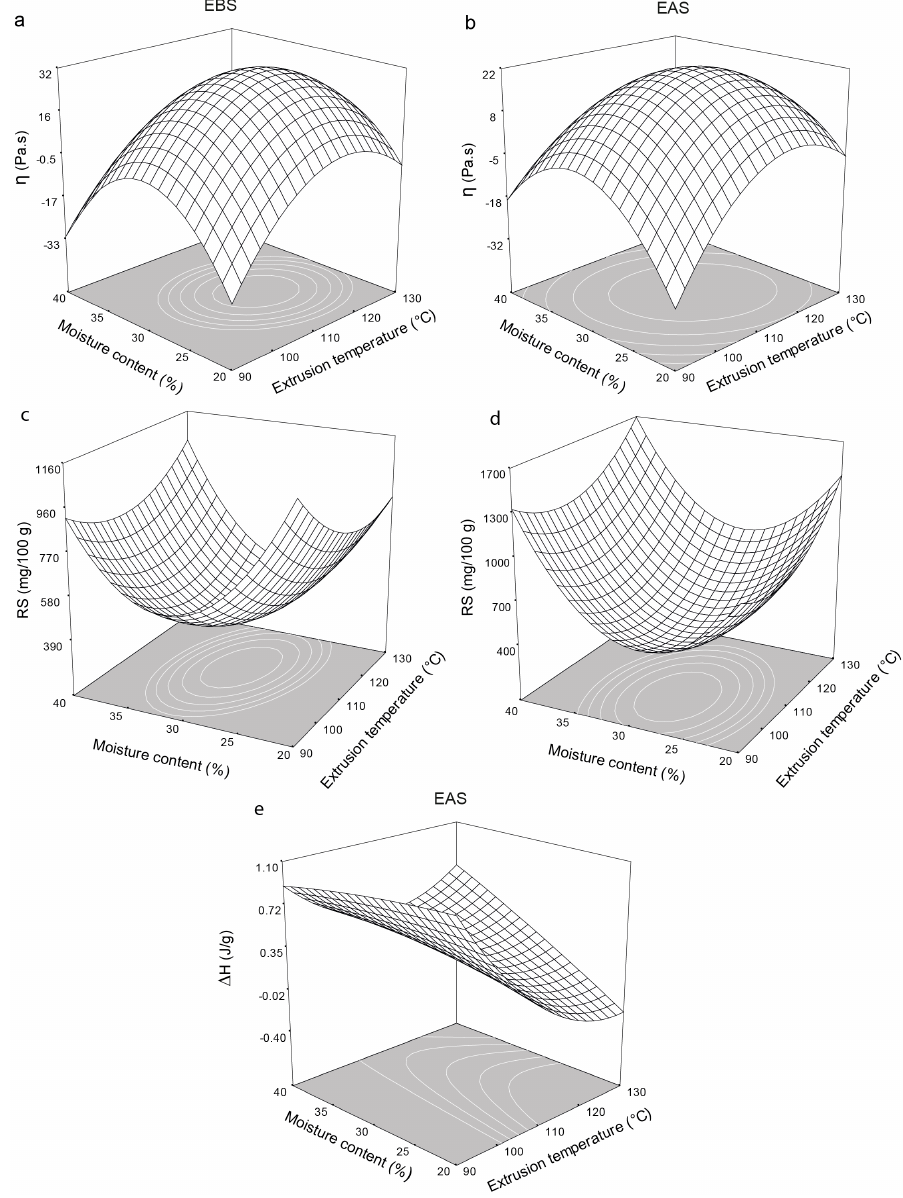
Figure 3. Effect of extrusion temperature and moisture content on apparent viscosity ( η ), resistant starch (RS) and enthalpy ( ∆ H) at screw speed of 280 rpm on extruded flours before the storage (EBS) and extruded flours after the storage at 4 °C for 120 h (EAS). a — η of EBS, b — η of EAS, c —RS of EBS, d —RS of EAS, e — ∆ H of EAS.